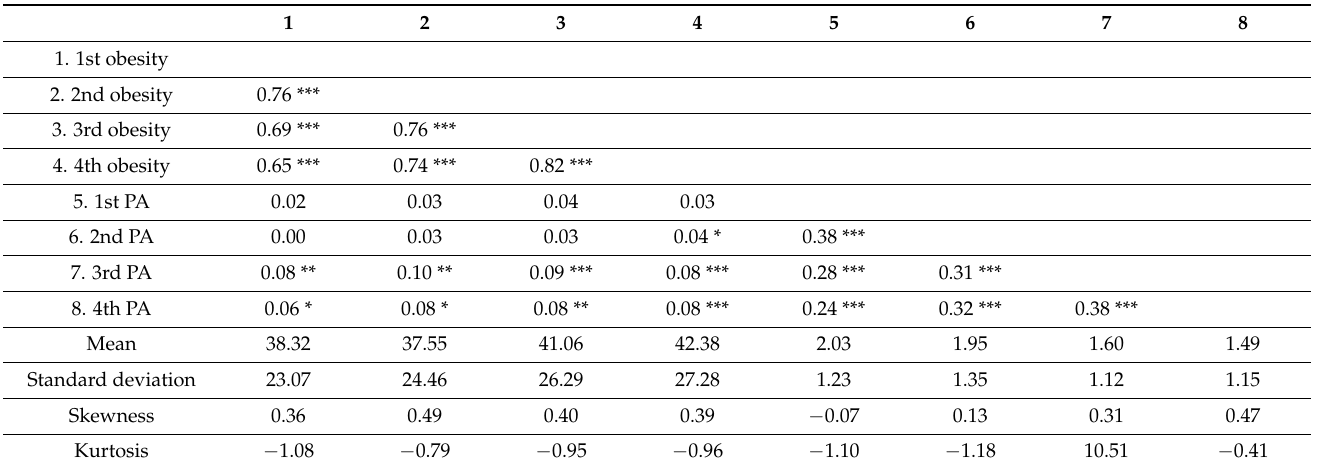
Table 1. Descriptive statistics and correlational matrix of PA and obesity status ( n = 1470).